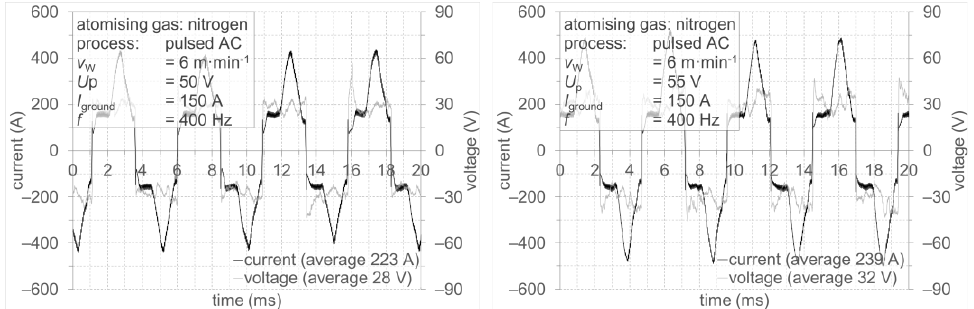
Figure 16. Current/voltage curve, pulsed alternating current, ( left ): U p = 50 V, ( right ): U P = 55 V. When the base current level is changed from 120 to 150 A, pulsed alternating current ( ∆ P = 1.3 kW) exerts a bigger influence on the spray power than pulsed direct current ( ∆ P = 0.2 kW). Figure 17 shows the current/voltage curves with different base currents. The average current, as well as the average voltage of the process,